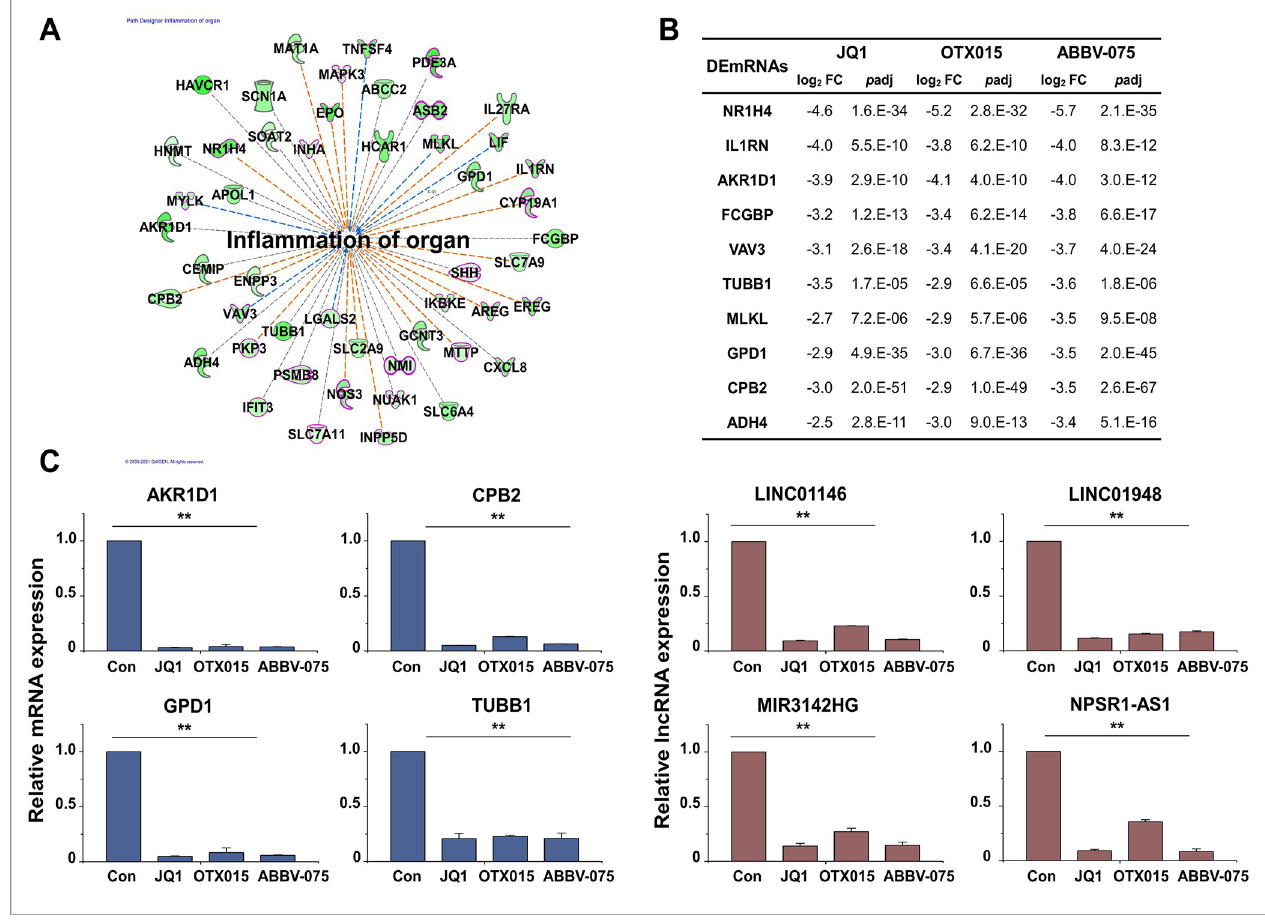
Fig 7. Biofunctional analysis of DEmRNAs related to inflammation of the organ. (A) IPA downstream effects analysis showing the mapping of most significant genes related to organ inflammation from the results of the biofunctional analysis in Module 1. Of the genes related to inflammation of organ, only apoptosis-related genes are shown in bold and red. (B) Log 2 fold changes and p adj in the expression of genes related to inflammation of the organ. (C) Expression levels of inflammation of organ-related mRNAs and lncRNAs were analyzed by qRT-PCR and normalized to GAPDH or U6 transcript levels, respectively. Overall, the inflammation of organ-related mRNAs and lncRNAs was inhibited by BET inhibitors. The data represent three independent experiments. The values are the mean ± SD of triplicate experiments ( �� p < 0.01).